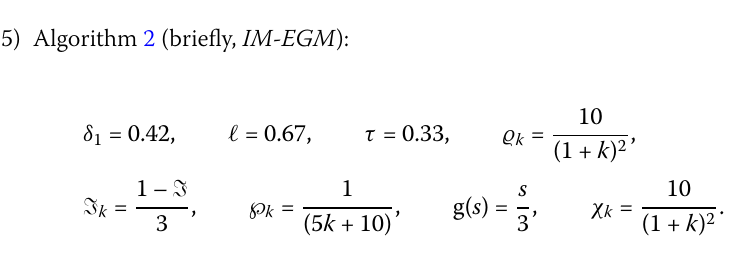
(5) Algorithm 2 (briefly, IM-EGM